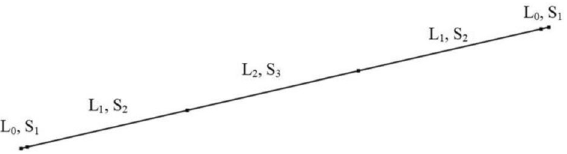
Figure 3. Equivalent pipe circuit with different segment length and cross-sectional areas.